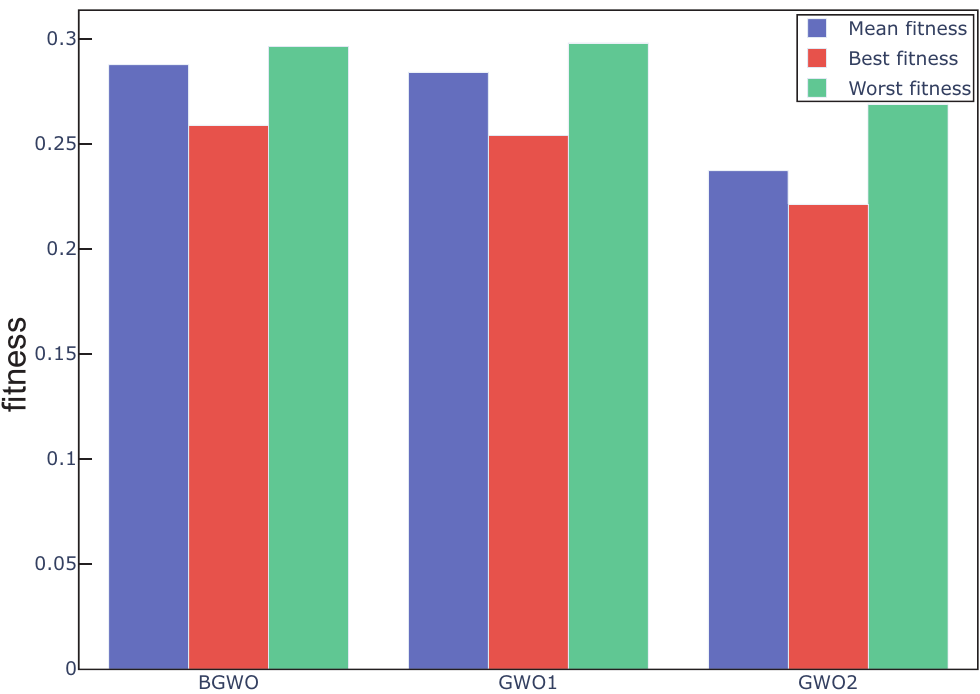
Figure 3. Mean, best, and worst fitness obtained from different algorithms over dataset1.